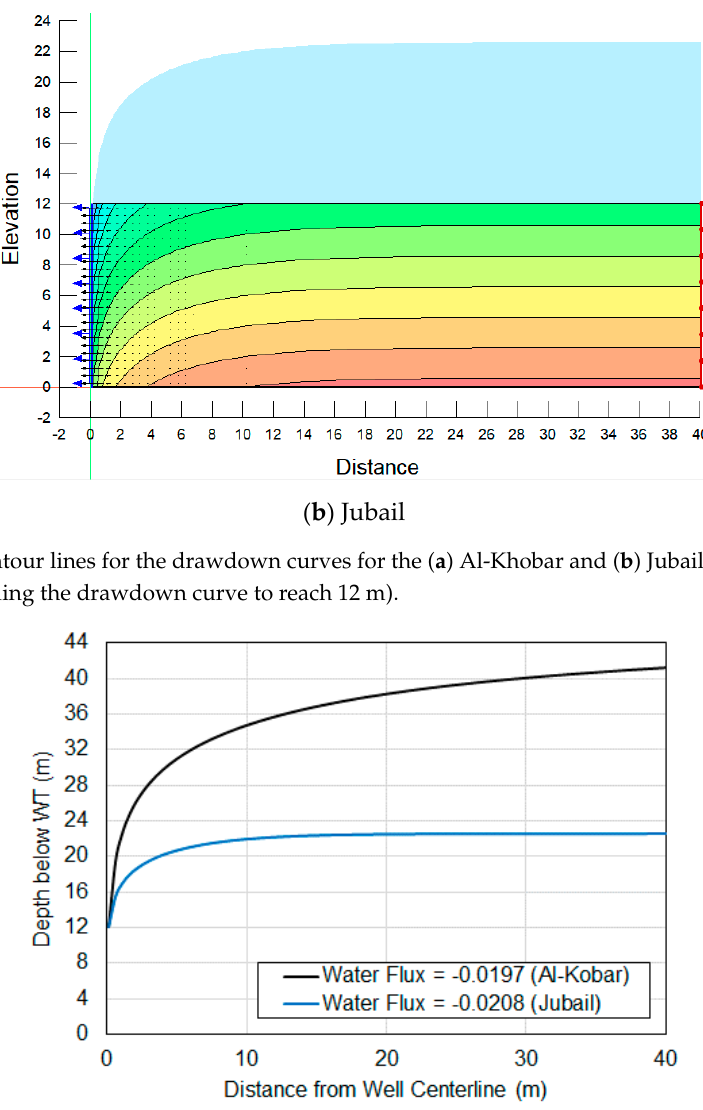
Figure 14. The drawdown curves resulted from water flux applied to the ( a ) Al-Khobar and ( b ) Jubail sites.